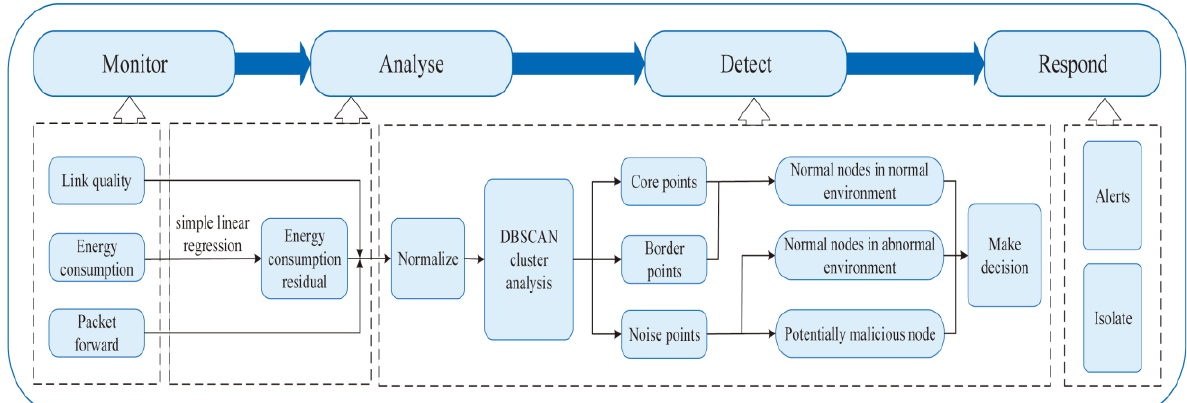
Figure 2. Framework for DOIDS.